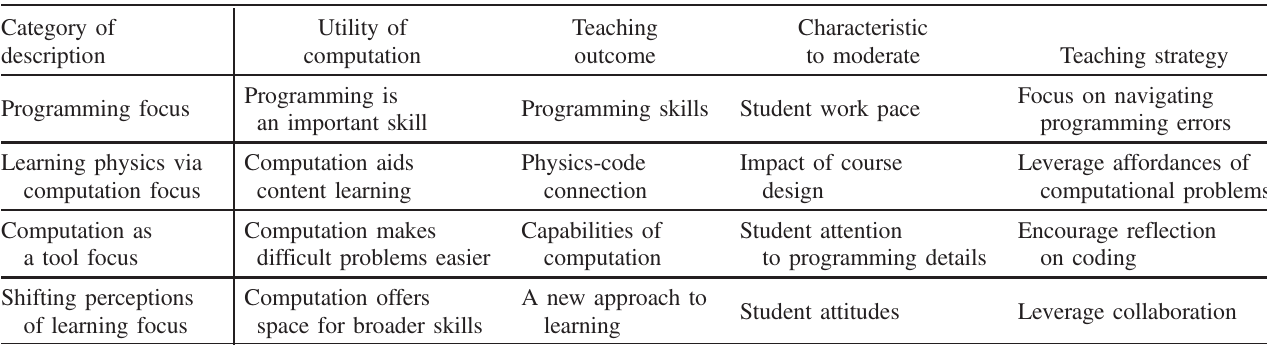
TABLE X. Final categories of description. Each category of description represents an approach to teaching computation based on learning assistants ’ experiences in the classroom. Column 1 gives the name of each category of description, and columns 2 – 5 indicate which variation within each theme that category of description is associated with. Note that columns 2 – 5 are equivalent to Tables VI –